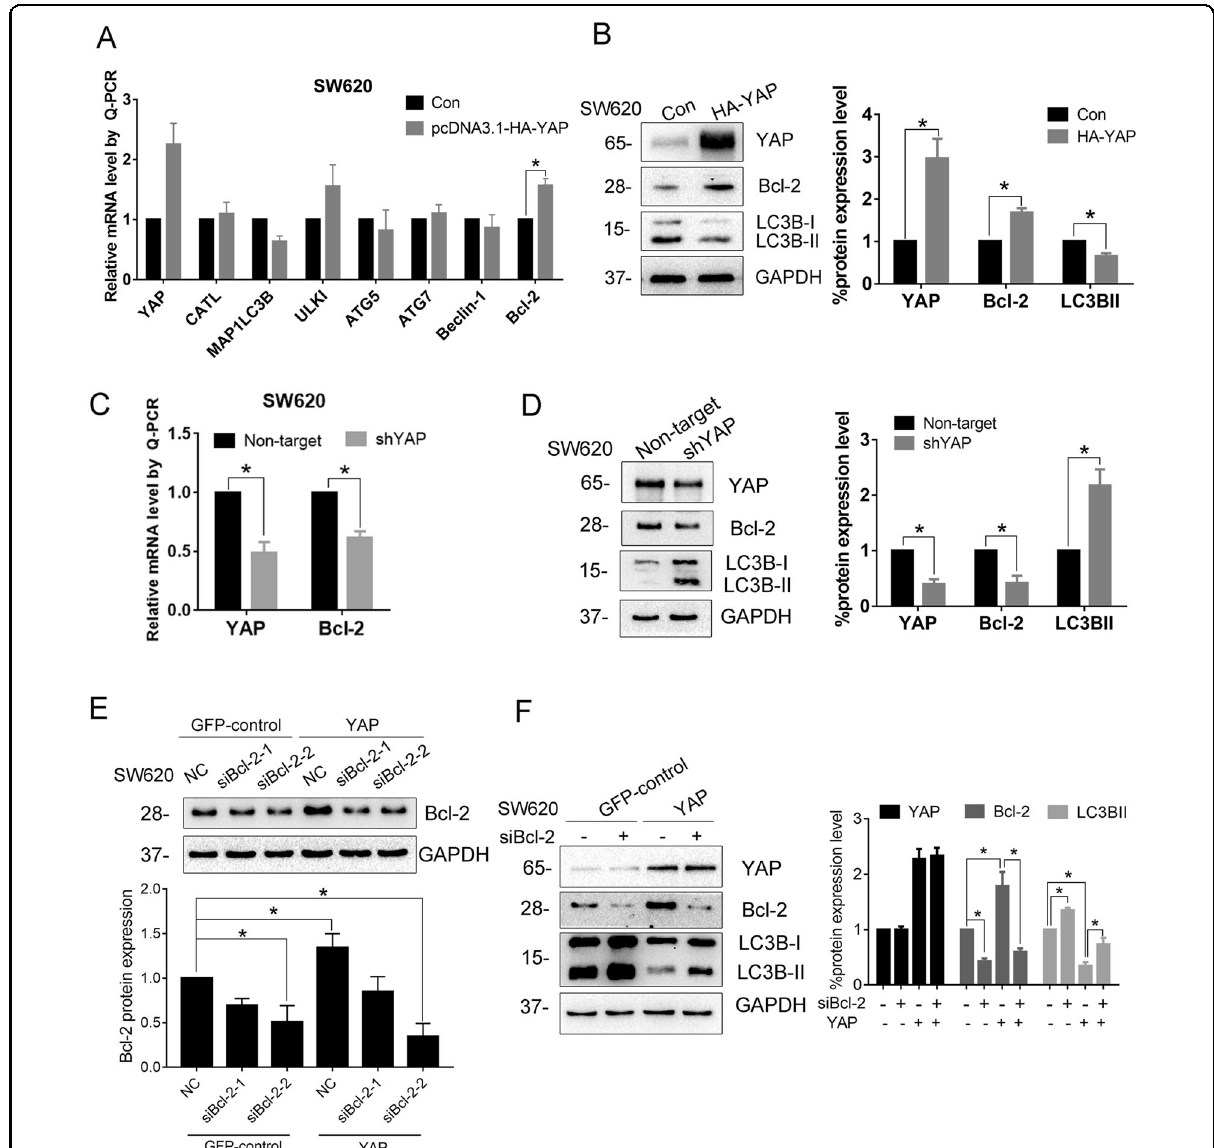
Fig. 2 Bcl-2 mediates YAP-induced autophagy inhibition. A mRNA levels of autophagy-related genes were analyzed by RT-qPCR in SW620 cells transiently transfected with pcDNA3.1-HA-YAP or control vector for 48 h. B Protein levels of Bcl-2 and the two forms of LC3B were investigated after SW620 cells transfected with pcDNA3.1-HA-YAP for 48 h. C mRNA and D protein levels of Bcl-2 after knocking down YAP expression in SW620 cells with speci fi c shRNA. Increased ratio of LC3B-II to LC3B-I indicates enhanced autophagy after knockdown of YAP. E The YAP-overexpressing (YAP) and control (GFP-control) SW620 cell lines were transfected with 100 nM of Bcl-2-speci fi c siRNA or NC siRNA for 48 h. Western blot was performed to evaluate Bcl-2 silencing ef fi ciency. F SW620 cell lines with YAP overexpression (YAP) and control cell line (GFP control) were transfected with 100